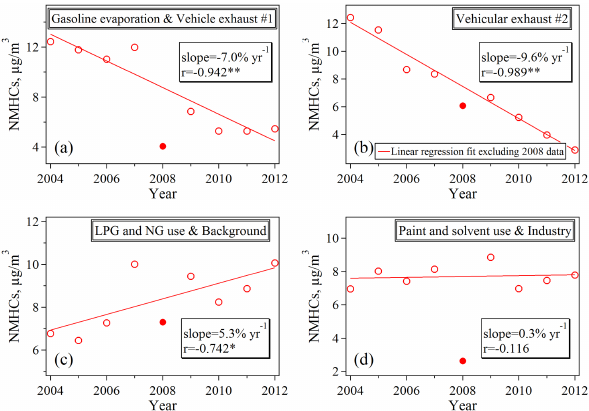
Figure 9. Temporal changes in NMHC concentrations during Au- gust from 2004 to 2012 contributed by four PMF-resolved factors: (a) gasoline and vehicle exhaust no. 1 , (b) vehicle exhaust no. 2 , (c) NG and LPG use and background , and (d) paint and solvent use and industry . The red solid lines represent linear regression fits of NMHC concentrations from each source during August from 2004 to 2012, excluding data for August 2008 (the red filled